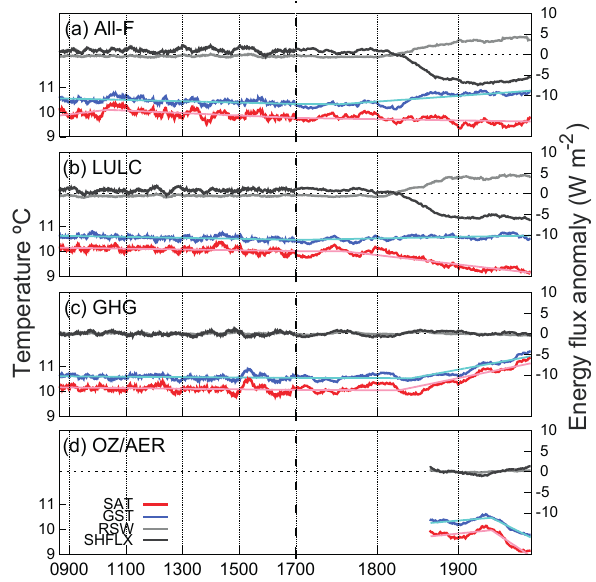
Figure 11. LM evolution of SAT, GST, reflected shortwave radia- tion (RSW) and surface sensible heat flux (SHFLX) for a grid point located at 40 ◦ N, 82 ◦ W in the south of the Great Lakes, US, in the ALL- F 2 , LULC 1 , GHG 1 and OZ/AER 1 simulations. The left axes correspond to SAT and GST, while the right axes correspond to the energy fluxes at the surface. Note that for the energy fluxes the anomalies with respect to 850–2005CE are shown, whereas for temperature absolute values are presented. All series are 31-year moving average filter outputs. For SAT and GST the result of the two-phase regression model is displayed with thin solid lines. Note the change in timing on the x axis after 1700CE.